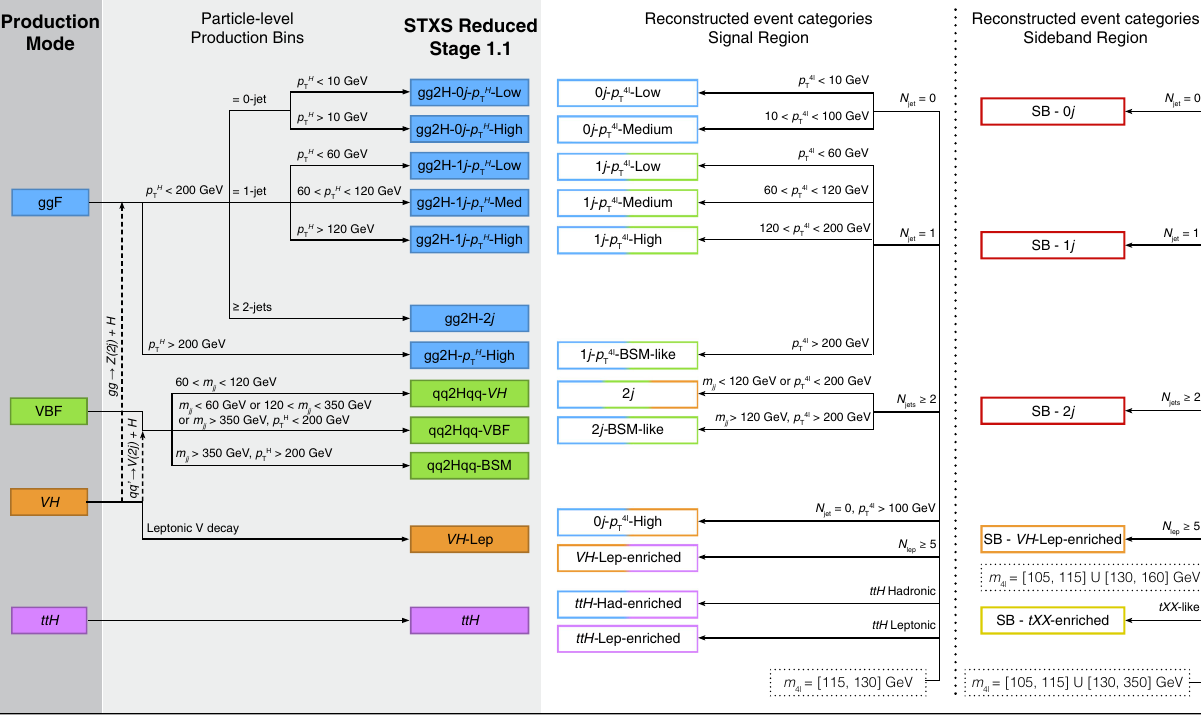
while the reconstructed signal region and sideband event categories are described in Sects. 5 and 6, respectively. The bbH ( tH ) contribution is included in the ggF ( ttH ) production bins. The colours of each recon- structedeventcategoryboxindicatesthecontributionsfromtherelevant production